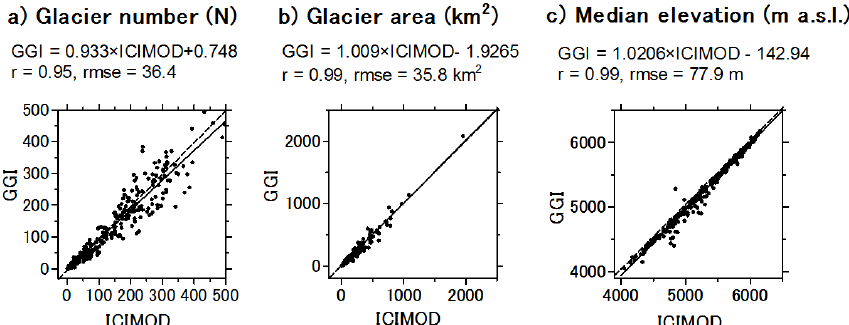
Figure 15. Scattergrams of (a) glacier number, (b) glacier area, and (c) area-weighted mean of median glacier elevation in each 0.5 ◦ grid cell of the ICIMOD inventory, plotted against the GGI in the Hindu Kush–Himalaya range. The dashed lines indicate 1:1 correspondence between ICIMOD and GGI. Also shown is the root mean square number (or area) difference ratio (%) against average number (or area) of ICIMOD. The solid lines are the best-fitting linear equations. All median elevations were calculated using the